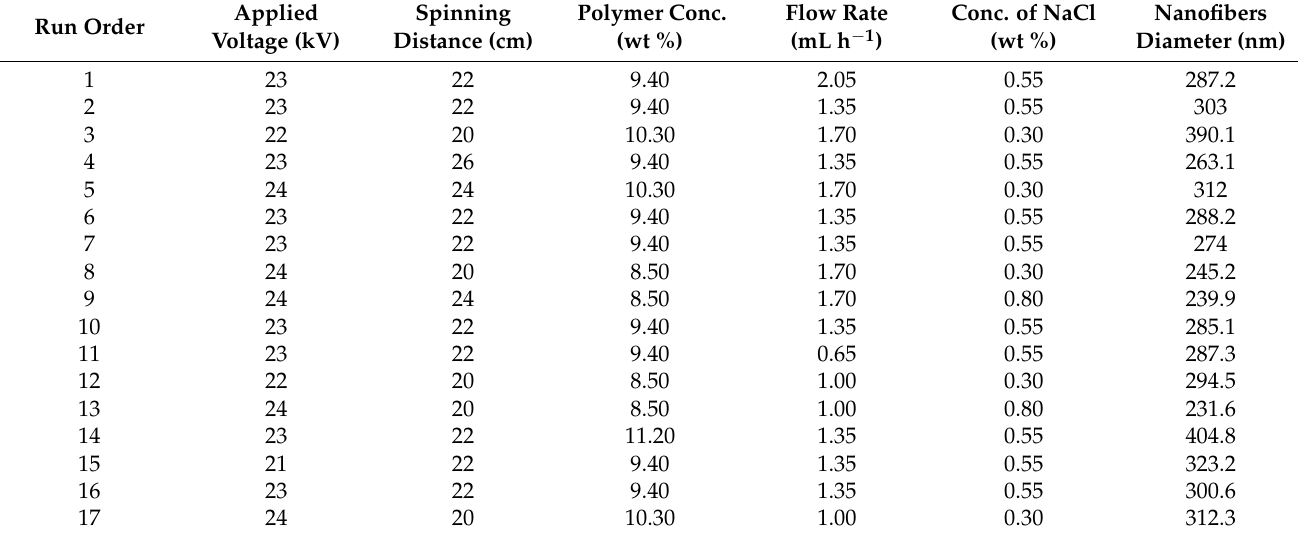
Table 3. Experimental design showing randomized list of the niobium–tungsten oxide nanofibers electrospinning experi- ments and the resulting fibers